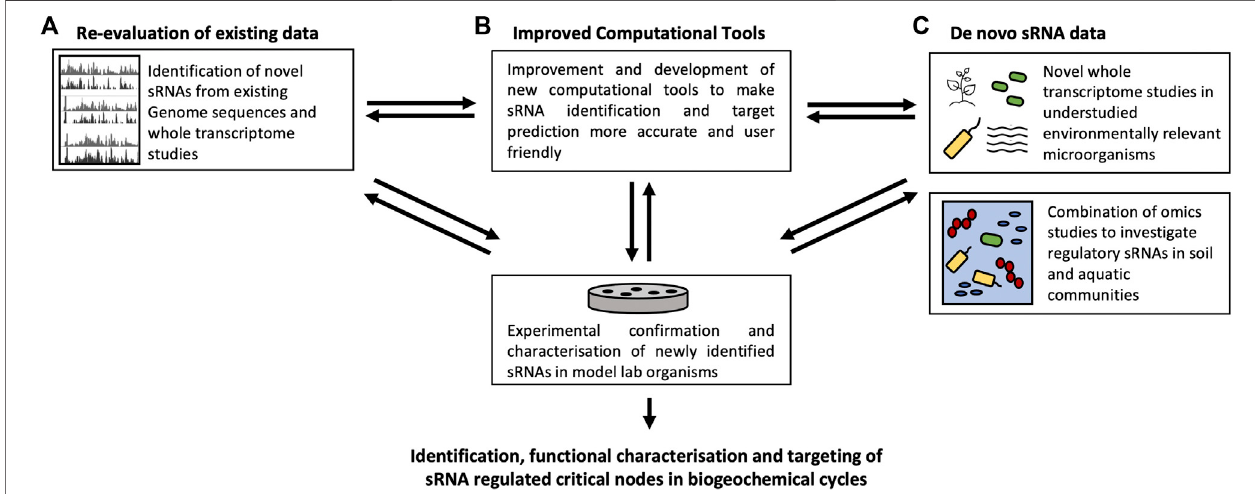
FIGURE 5 | Roadmap for the progression of sRNA research in environmental cycles includes (A) the Re-evaluation of existing data, (B) the development of improved computational tools and (C) the generation of de-novo sRNA data.